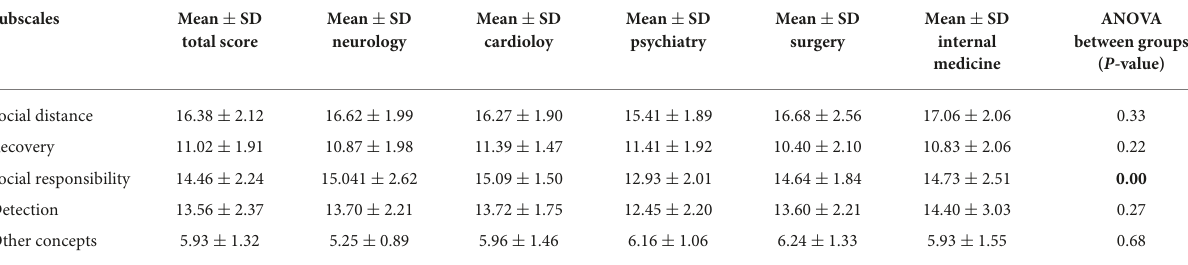
TABLE 3 Comparison of OMS-HC subscales between different groups.